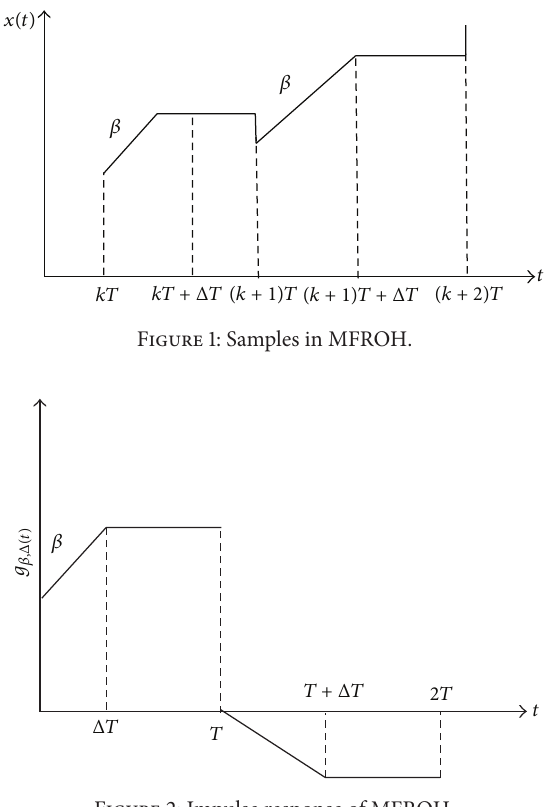
Figure 2: Impulse response of